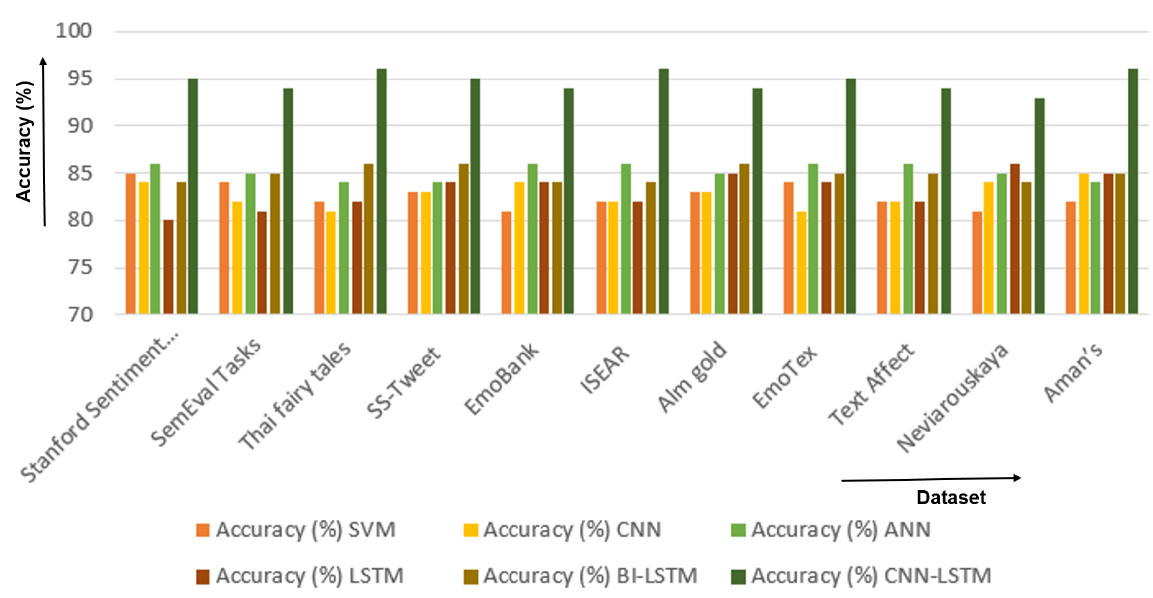
Figure 9. Performance analysis for BOW + IF-IDF with CNN-LSTM based on accuracy. (“Stanford Sentiment...” means “Stanford Sentiment